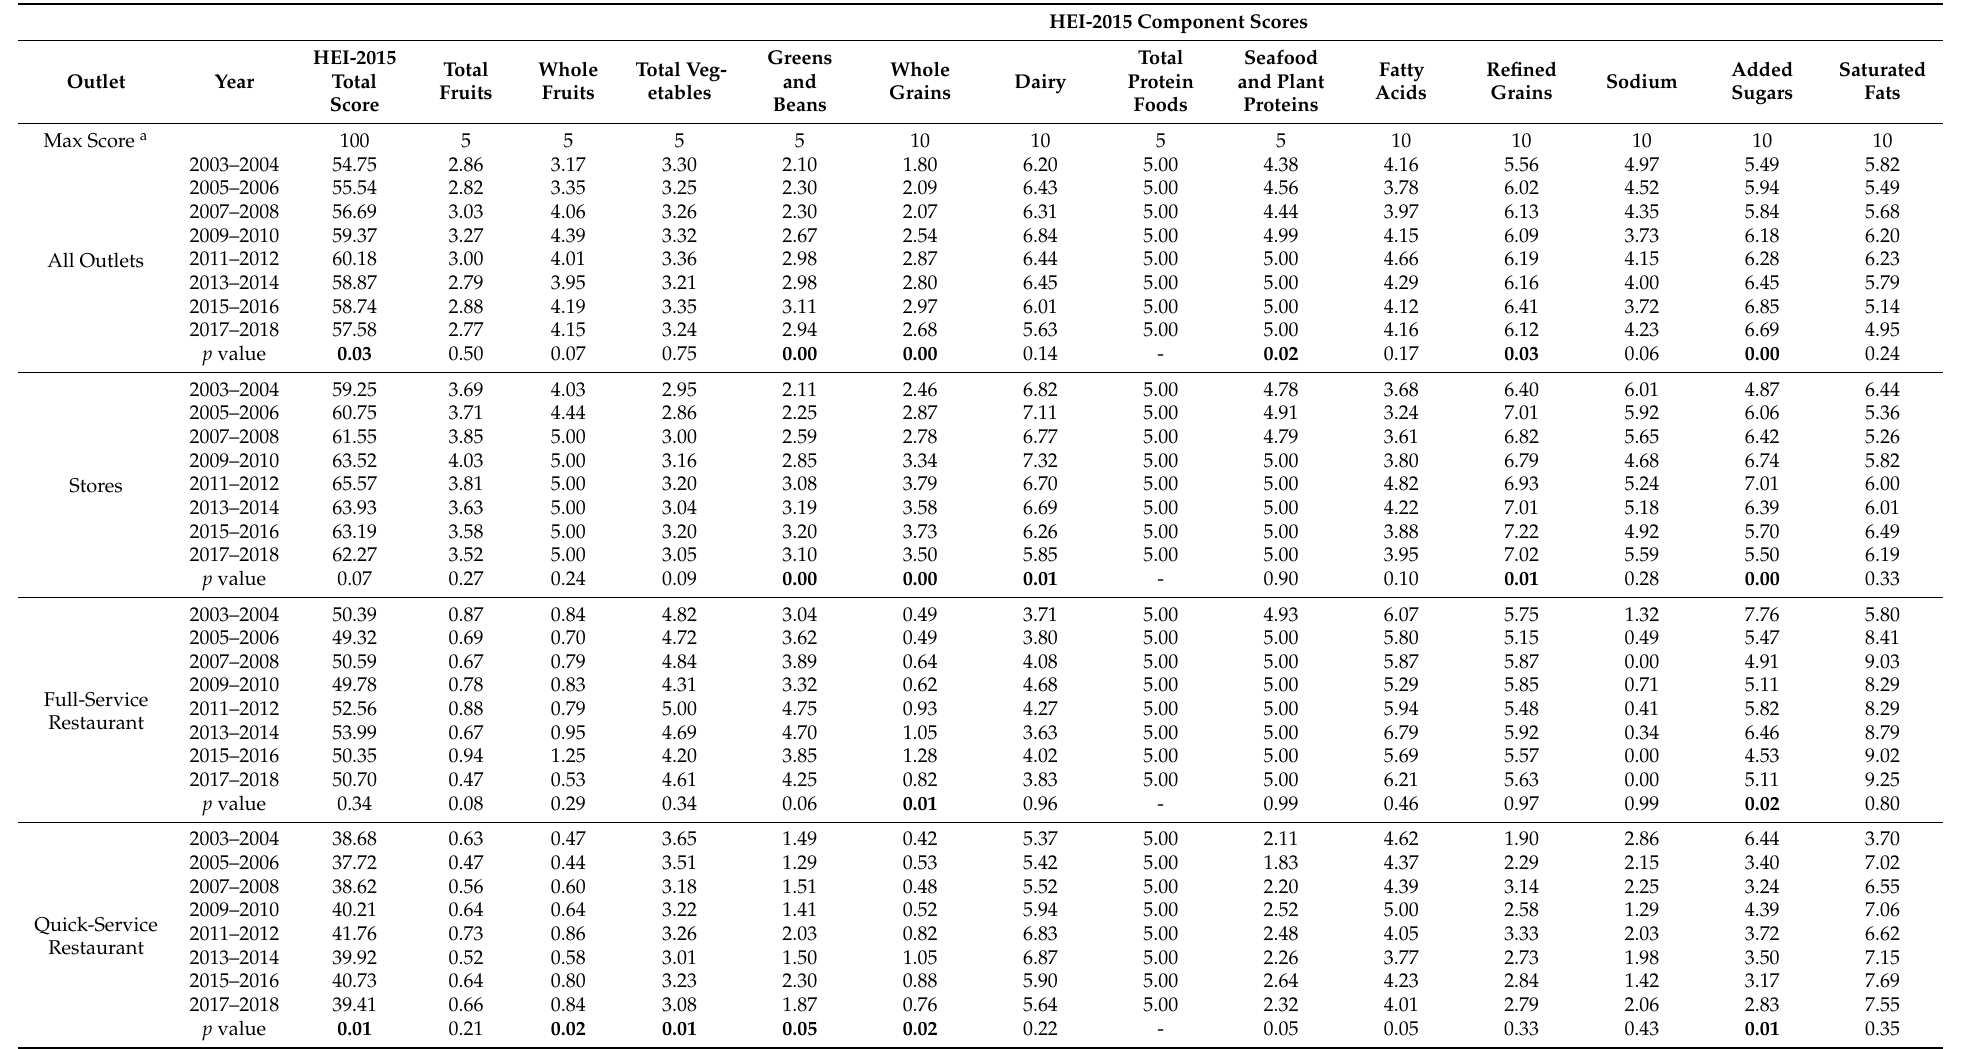
Table 1. HEI-2015 total and component scores by food outlet category per NHANES cycle